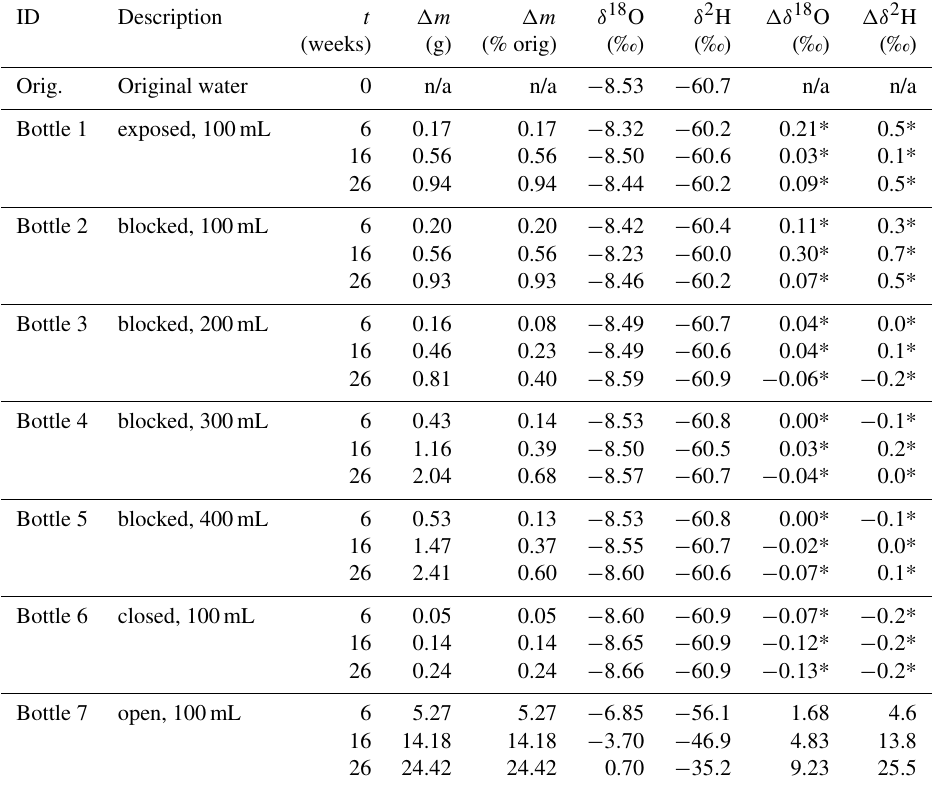
Table 1. Overview of collected samples and associated water losses and isotopic shifts. Water losses (cid:49)m are given as absolute mass losses (g) and as percentages of the original water amount (% orig). Isotopic signatures ( δ 18 O and δ 2 H) and isotopic shifts away from the original composition ( (cid:49)δ 18 O and (cid:49)δ 2 H) are given in ‰ V-SMOW. Note that the analytical precisions for δ 18 O and δ 2 H account for ± 0 . 15‰ and ± 0 . 6‰ ( ± 1 σ) , respectively.